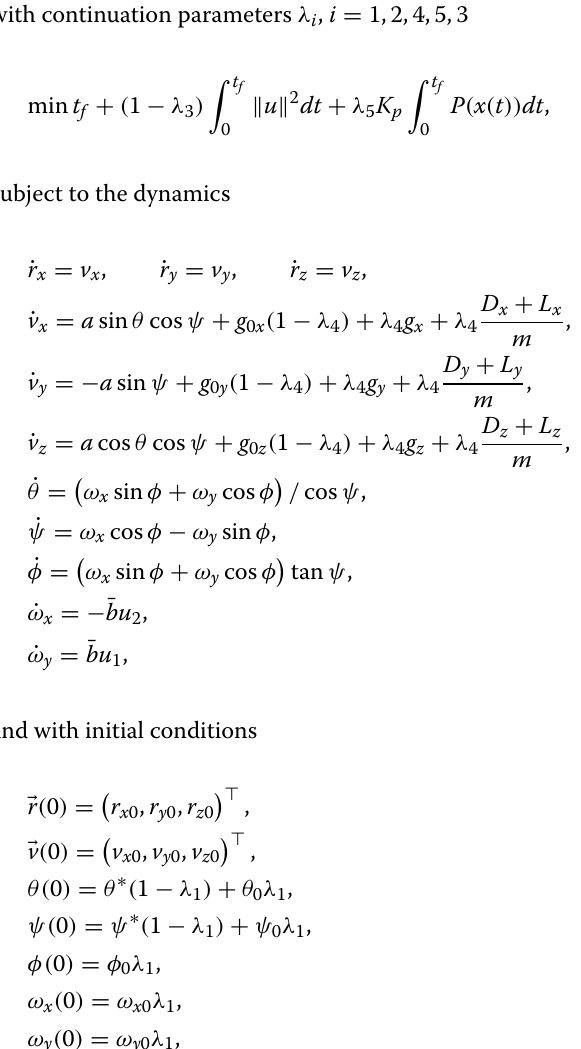
Fig. 16 Continuation procedure for solving ( P A